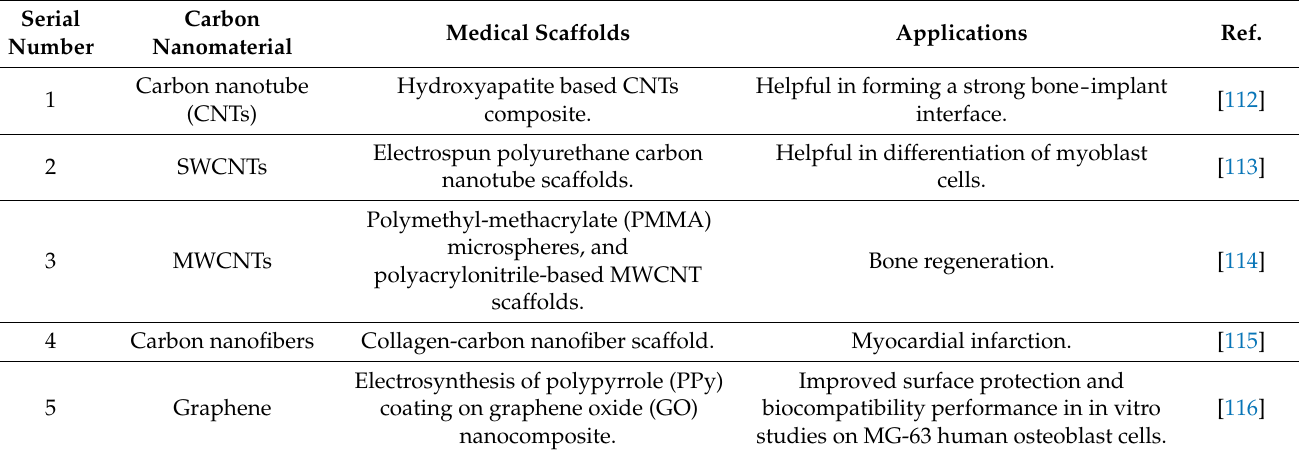
Table 3. Different medical implants based on CNMs and their biomedical